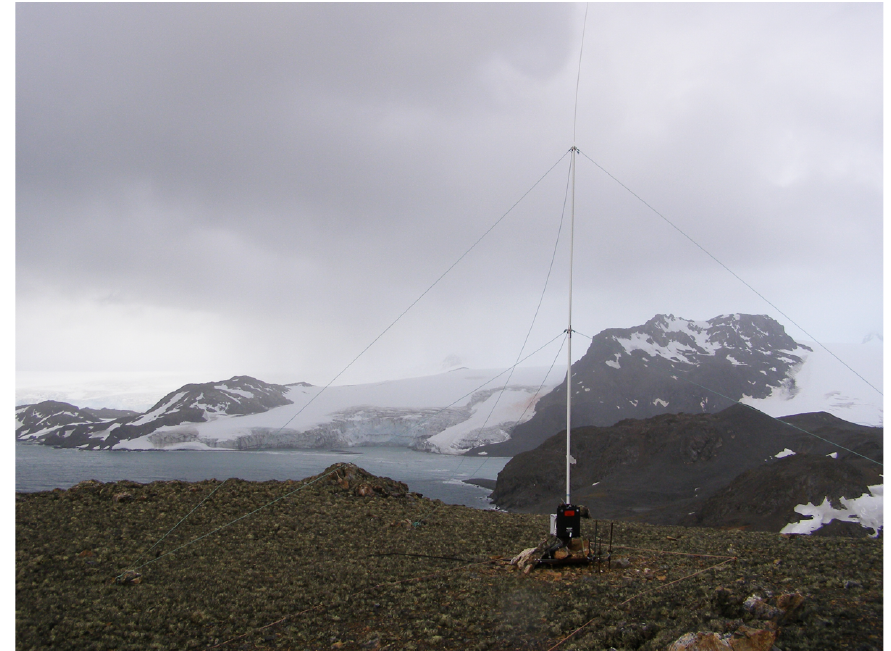
Figure 1. Antenna of the oblique ionosonde transmitter placed at the